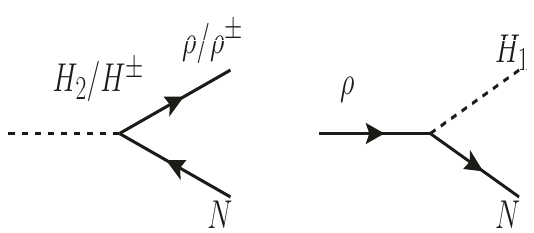
Figure 12 . Feynmann Diagram for the dominant production of N as well as its late production from the decay of ρ